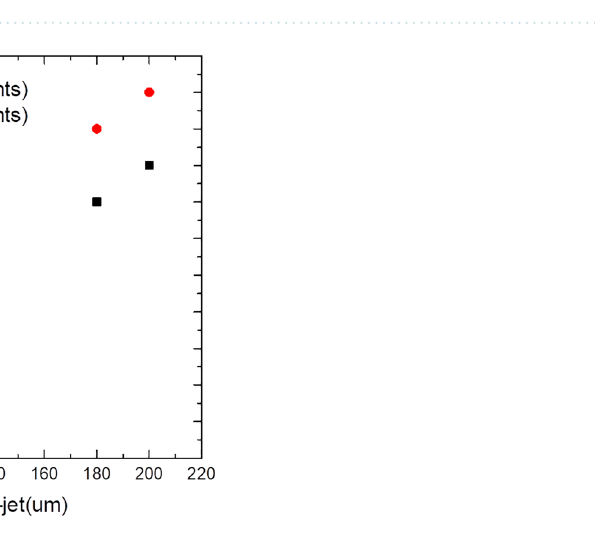
Figure 14. The photos of CE-Jet and the microstructure of photoresist at certain printing parameters: ( a ) experimental photo ( b ) simulation result.